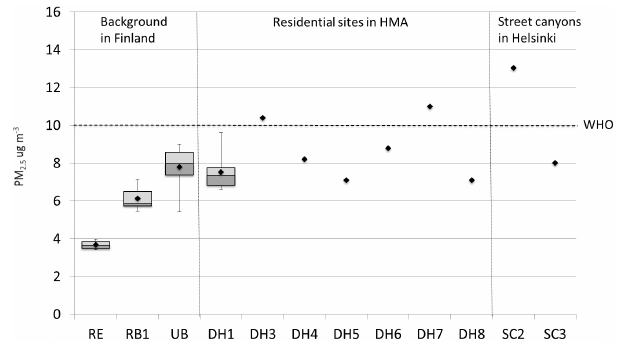
Figure 3. Annual means of PM 2 . 5 concentrations (µgm − 3 ) for dif- ferent BaP measurement stations in Finland. The box whisker plot represents the smallest value, the 0.25 percentile, the median value, the 0.75 percentile, and the largest value for each measuring site. The WHO air quality guideline is marked as a dashed line. The pre- sented PM 2 . 5 data are for the same years as for BaP in Fig. 2 and Table 1, except for the value at station RE, which is only for the years 2011, 2012, 2014, and 2015 (HMA: Helsinki metropolitan